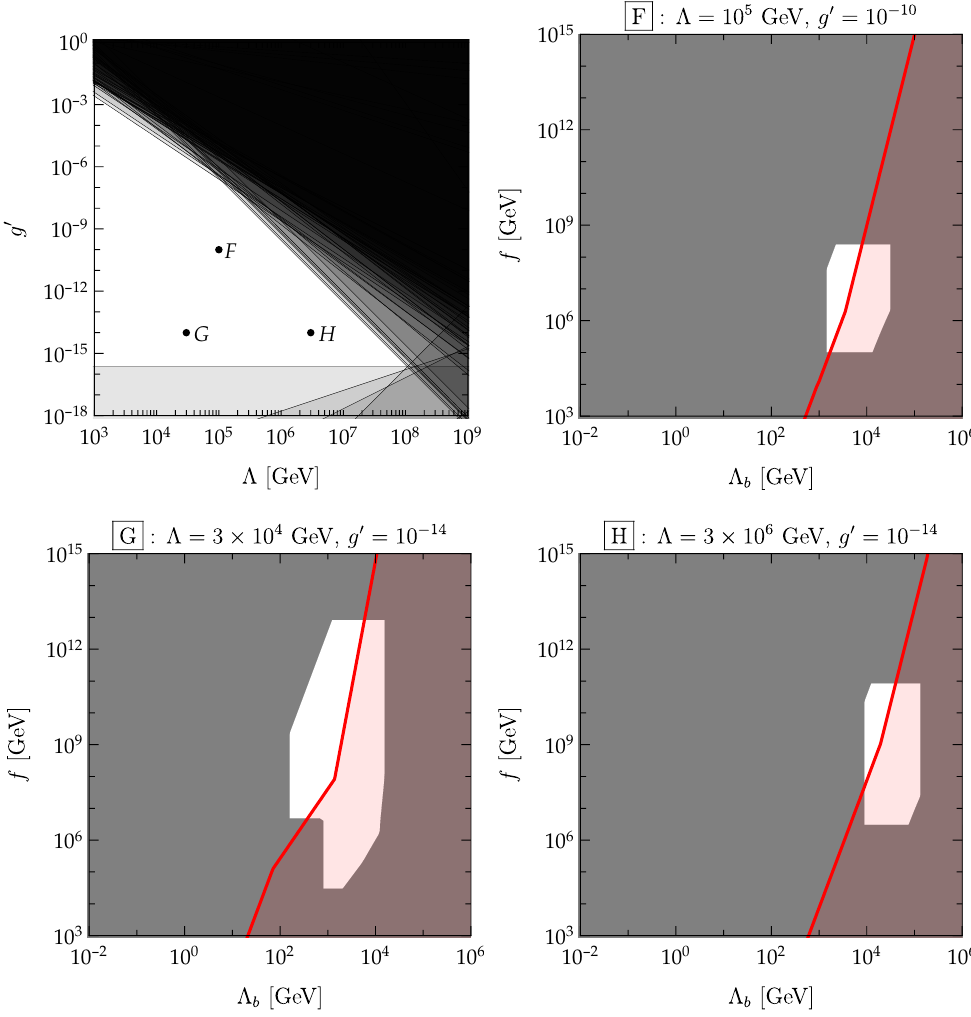
Figure 9 . Relaxation with EW gauge boson production during in(cid:13)ation. White region is the would- be allowed region that was derived in ref. [14], not including the e(cid:11)ect of relaxion fragmentation. The red region is the new exclusion due to relaxion fragmentation. For more details on the delimitating lines, see (cid:12)gures 31, 32, 33 in appendix